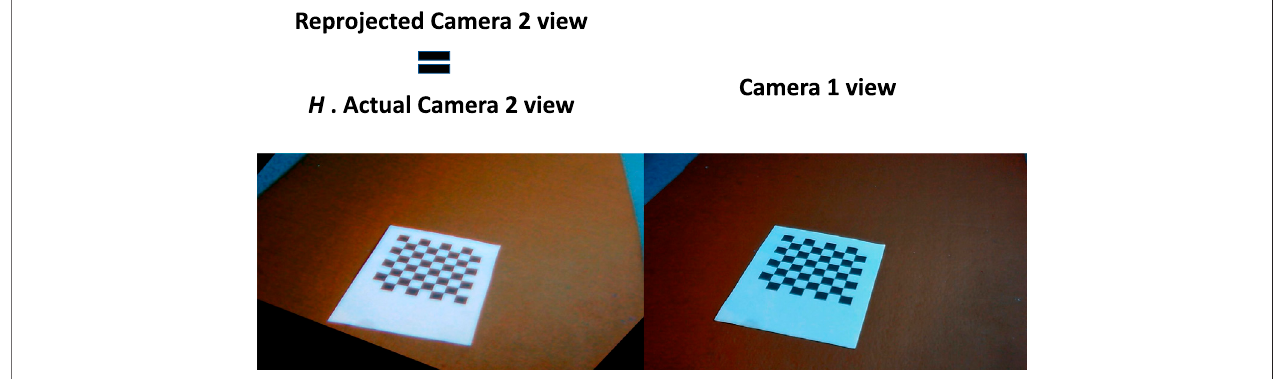
FIGURE 4 | Reprojection of camera 2 image to camera 1 image using the homography matrix.